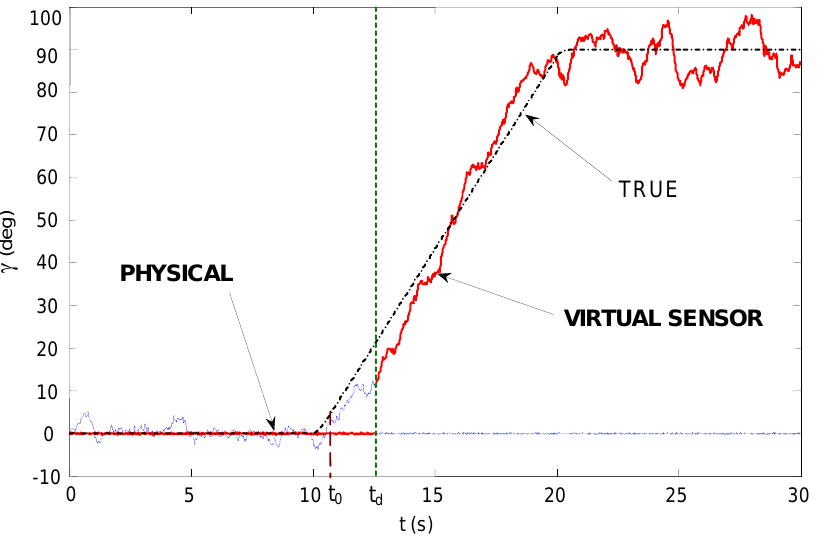
Figure 6. Wing sweeping angle estimation in case of sensor failure.